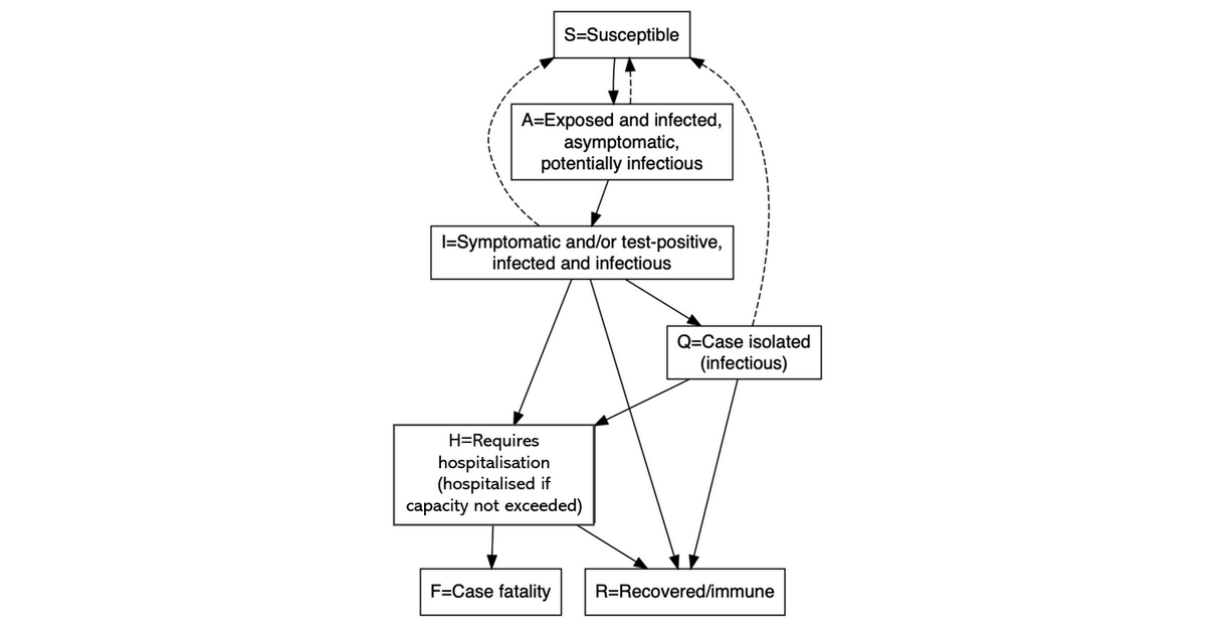
Figure 1. Structure of the COVID-19 Open-source Infection Dynamics stochastic individual contact model. The dashed arrows represent interpersonal interactions through which transmission of infection may occur. The solid arrows indicate possible transitions between compartments. COVID-19: coronavirus